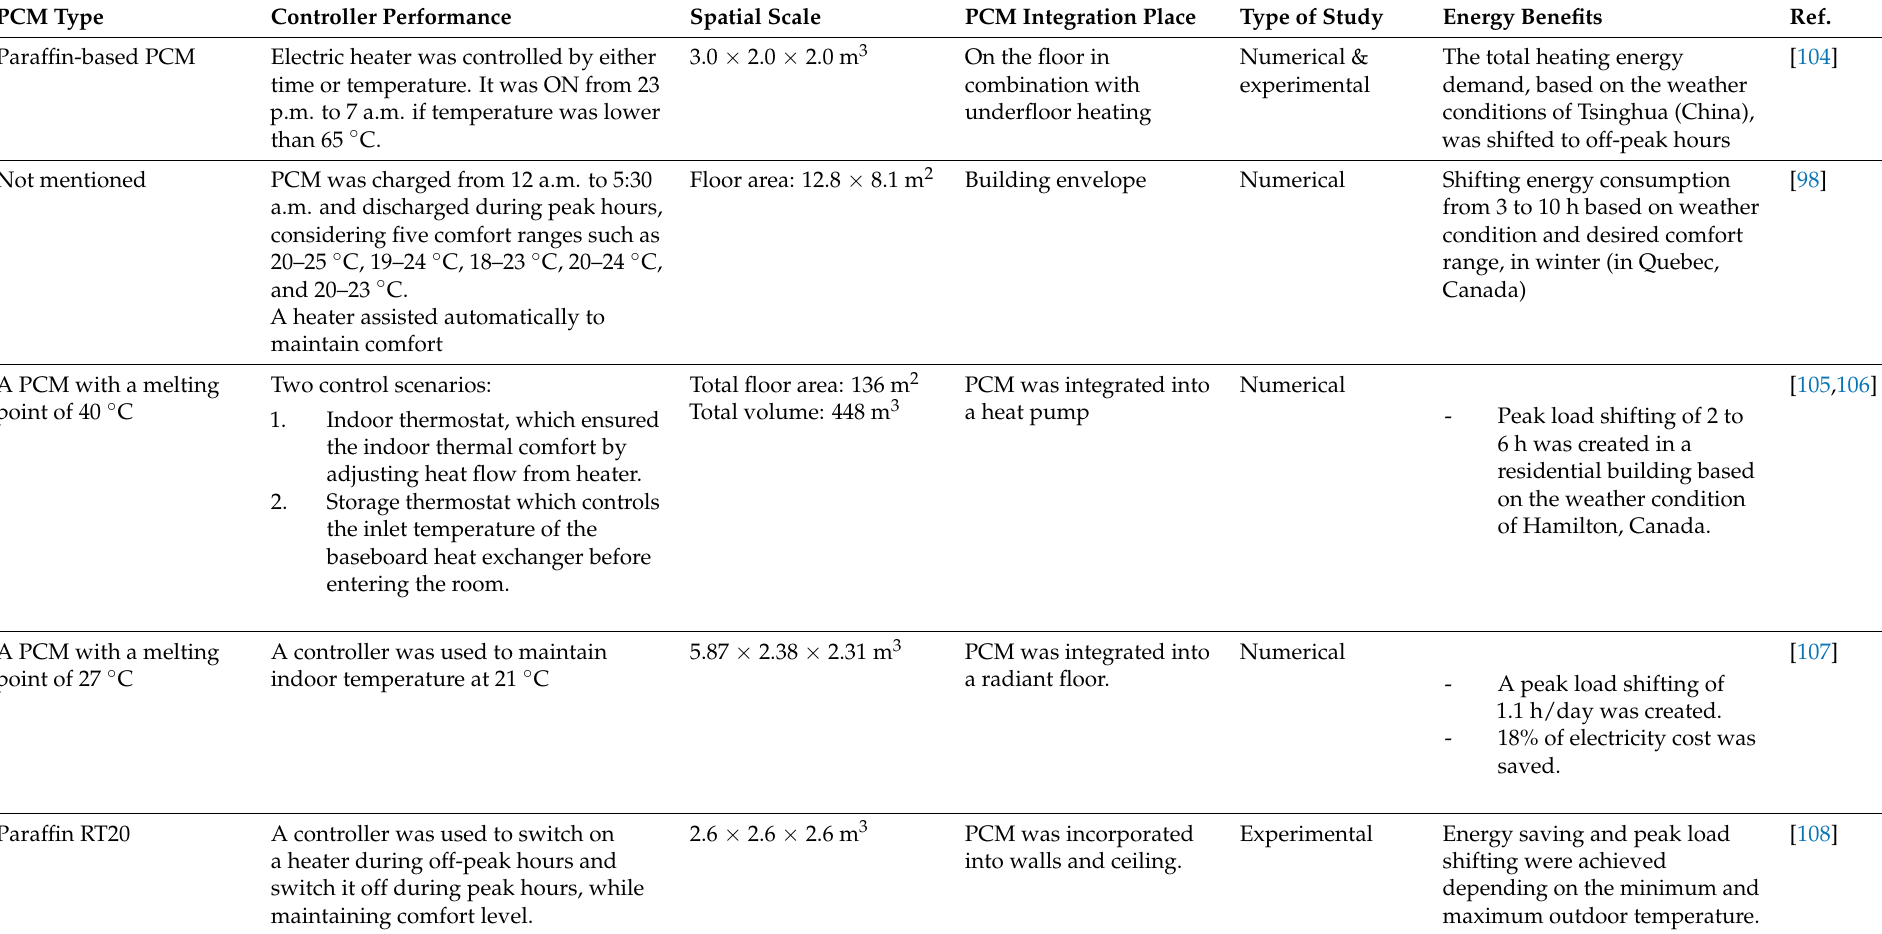
Table 4. Application of ON/OFF controller in PCM-enhanced buildings used for peak load